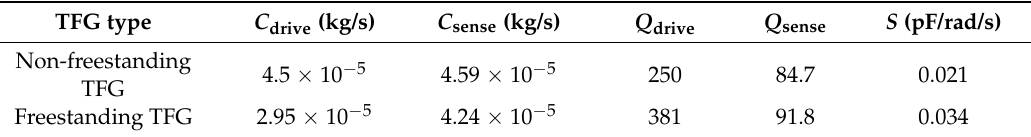
Table 2. Damping coefficient, quality factor, and sensitivity of the drive and sensing mode of the non-freestanding and freestanding TFG for comparison.